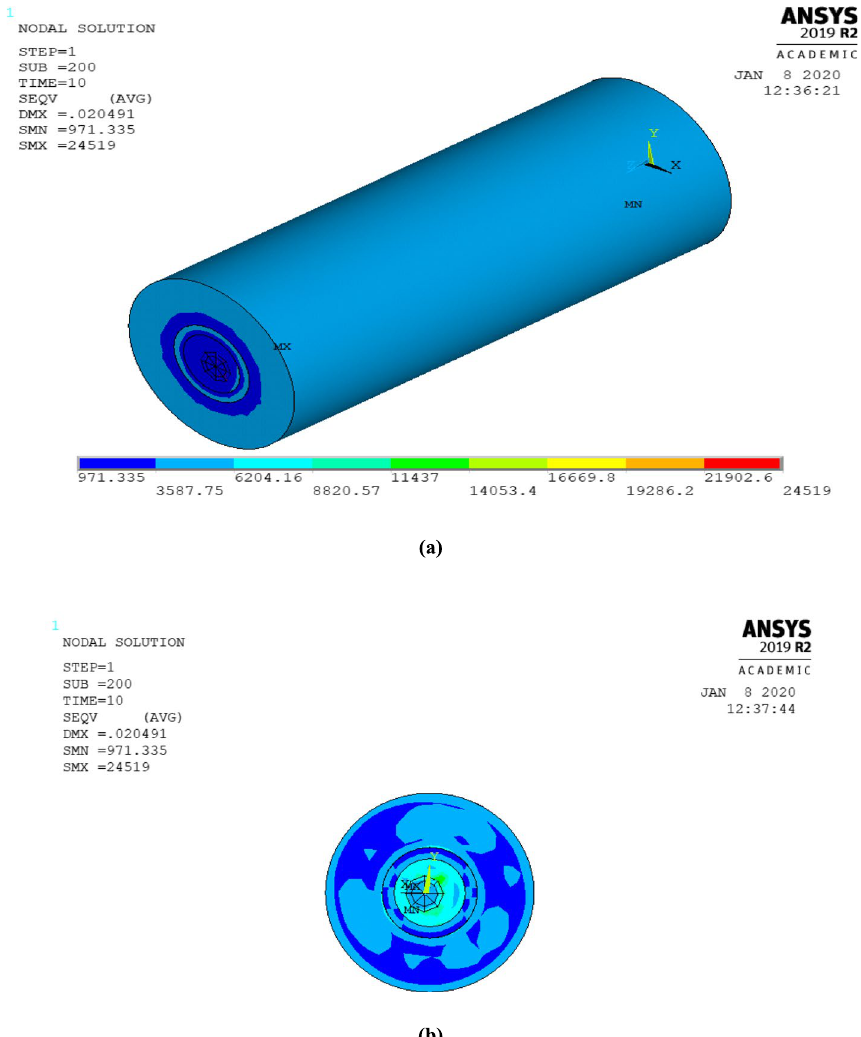
Fig. 14 a Combined stresses from static model. b Combined stresses from static